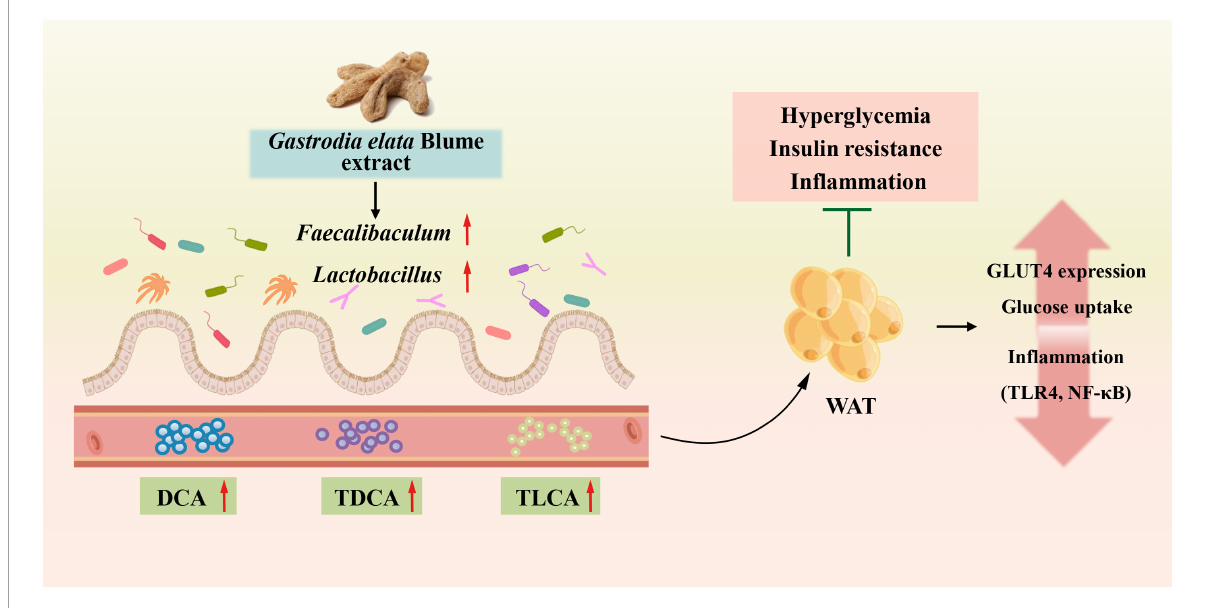
FIGURE7 GEBE ameliorates T2D by increasing GLUT4 expression in WAT, remodeling the gut microbiota, and modifying serum bile acid